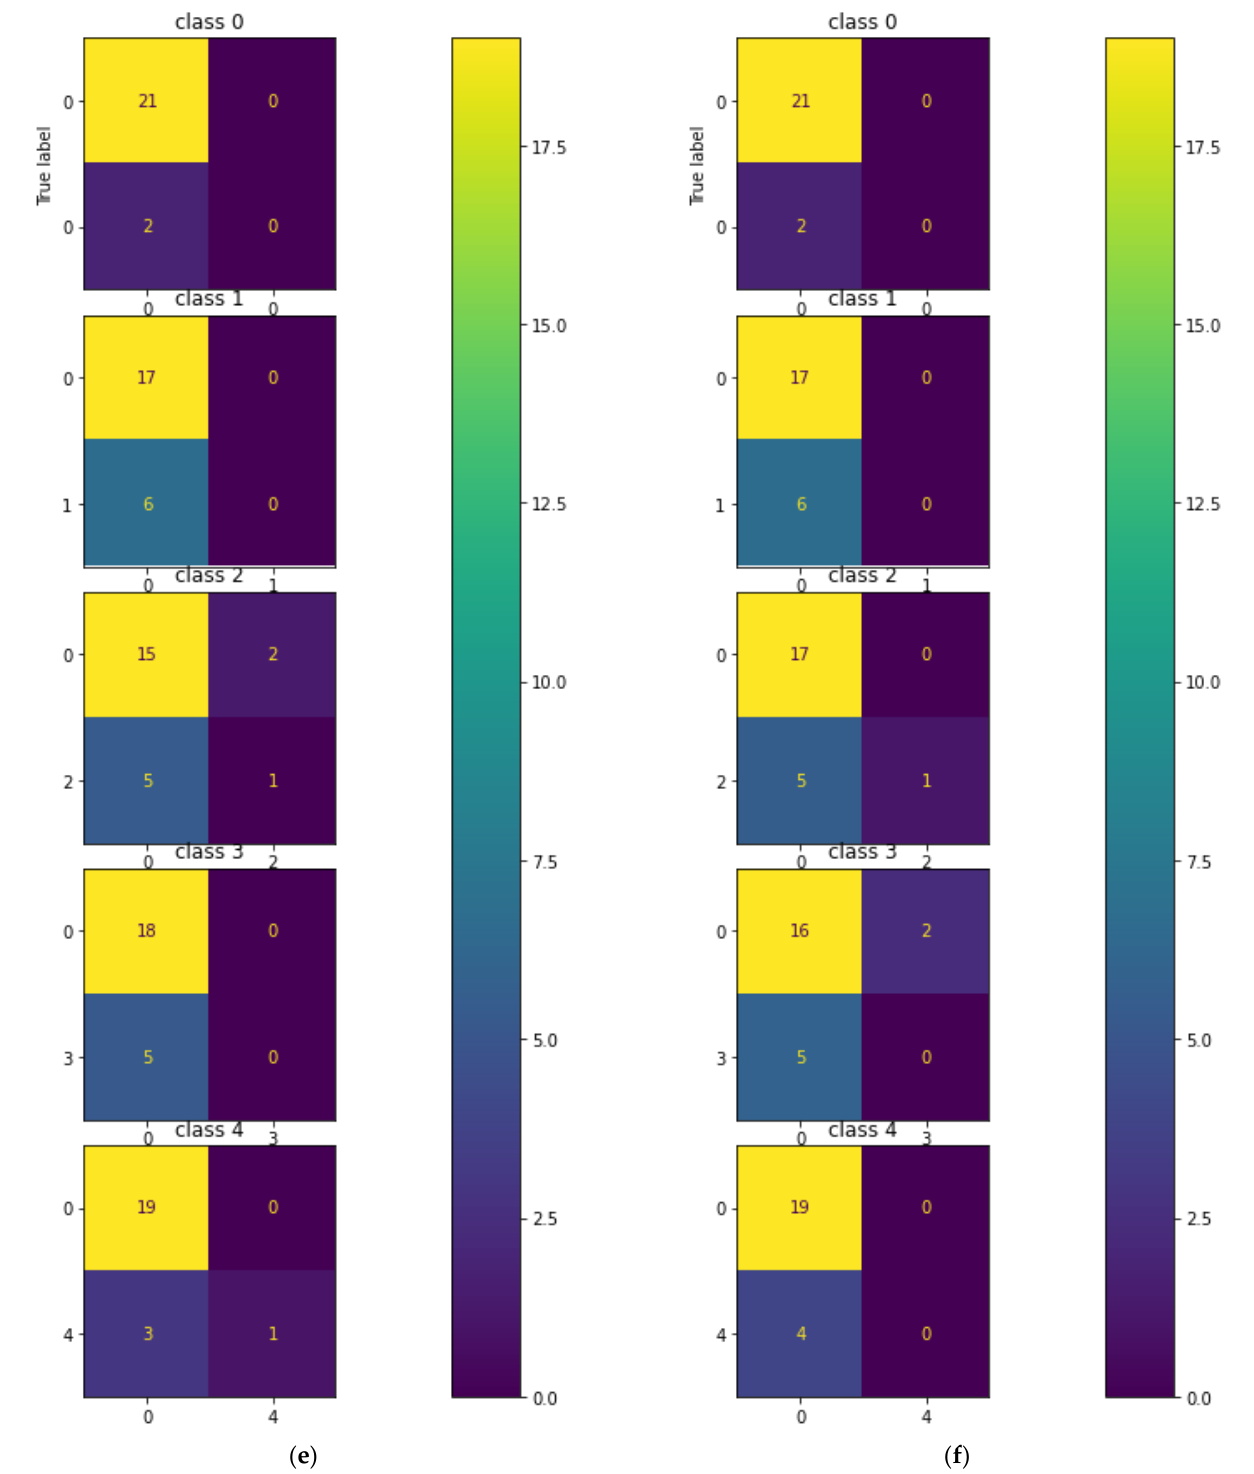
Figure 12. Multi-class confusion matrix for the whole information dataset: ( a ) CNN; ( b ) KNN; ( c ) MLP; ( d ) DT; ( e ) RF; ( f ) ET.